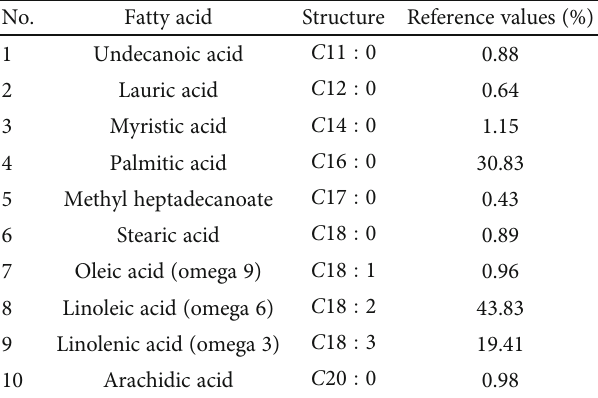
Table 4: Fatty acid content in Spirulina microalgae